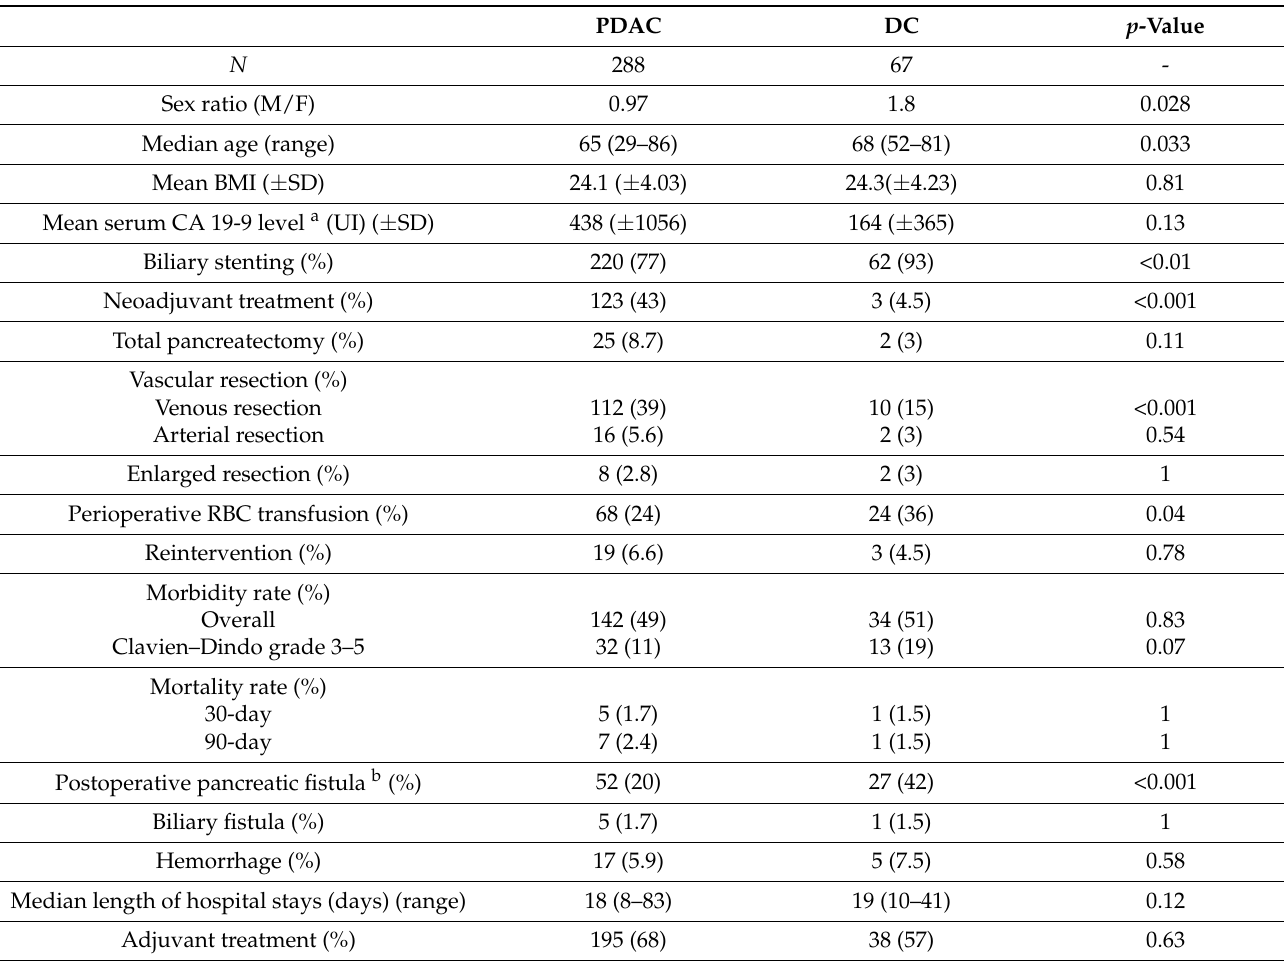
Table 1. Comparisons of baseline demographics, operative data, and postoperative courses between patients with distal cholangiocarcinoma (DC) and those with pancreatic ductal adenocarcinoma (PDAC). PDAC